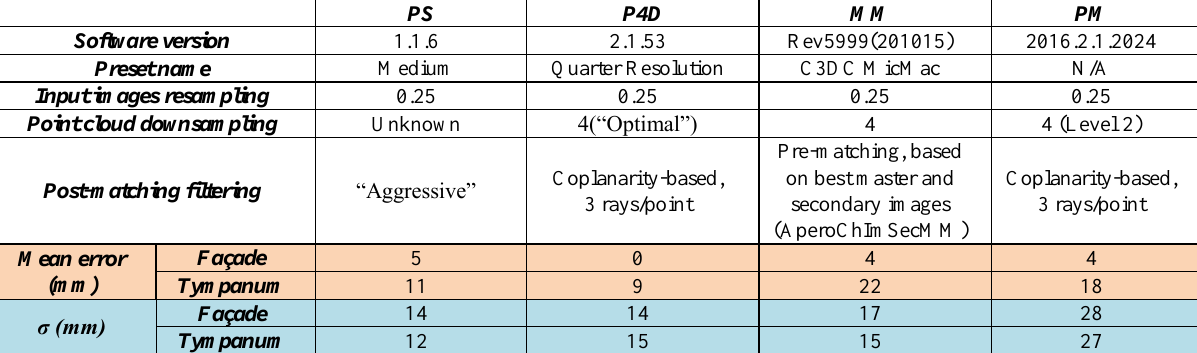
Table 2. Dense matching settings for the St-Pierre Albris dataset and the results of its comparion to laser scanner data.